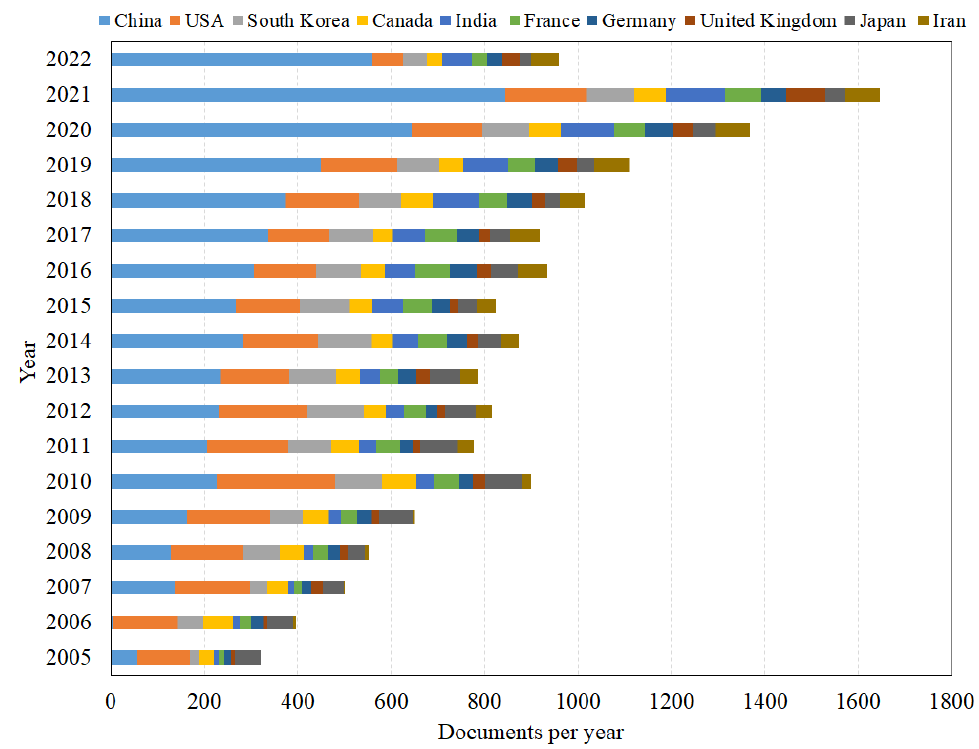
Figure 6. Map distribution of the top 10 countries.